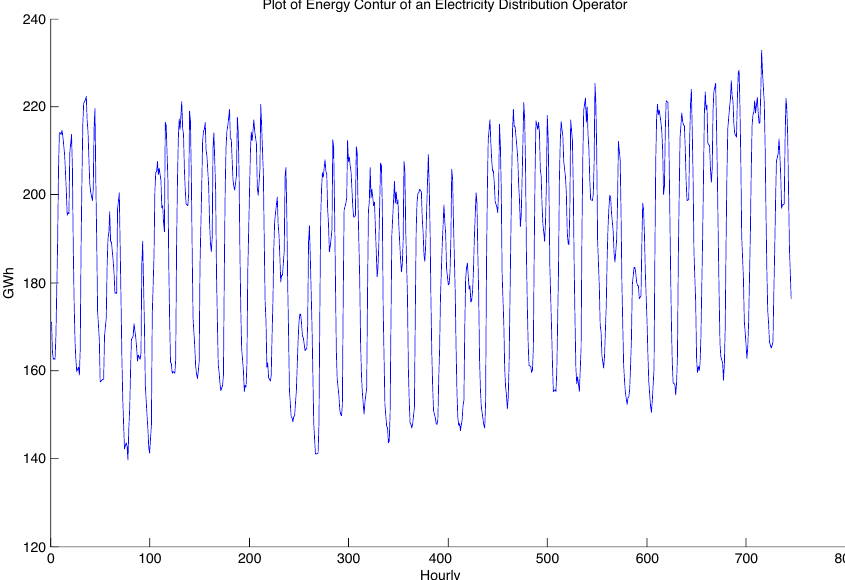
Figure 3. Frequency representation of the energy contour for an Electricity Distribution Branch. The signal x ( t ) that represents the energy contour of the analyzed Electricity Distribu- tion Branch, which is periodic for T = 24 h, was developed in Fourier series according to Equation